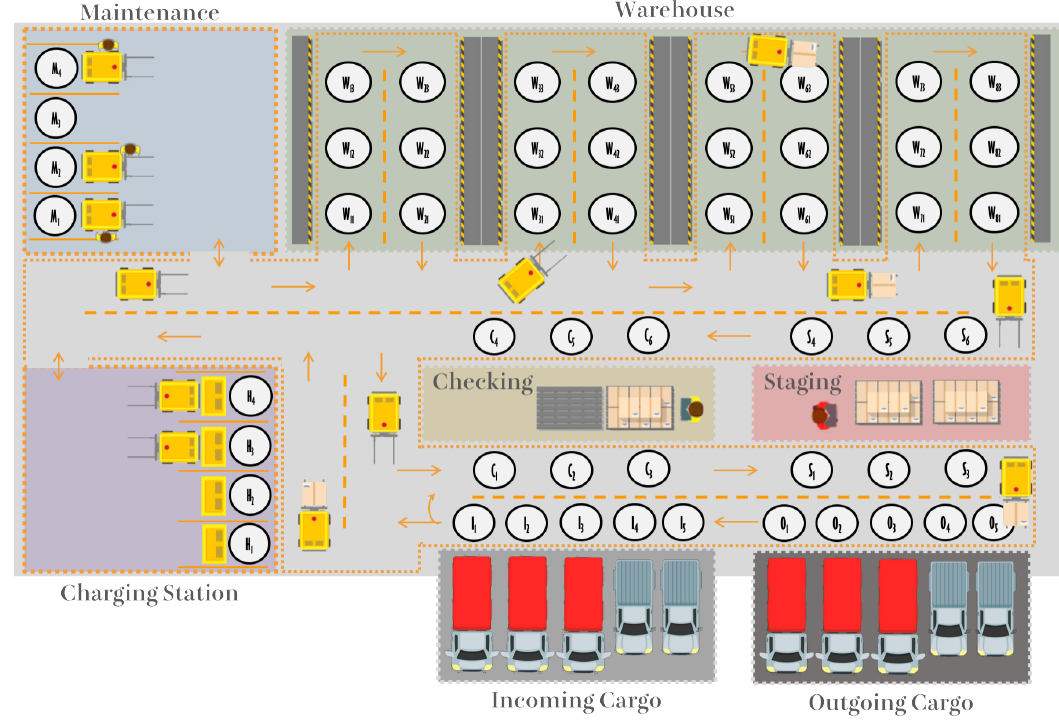
Figure 1. Organization of warehouse